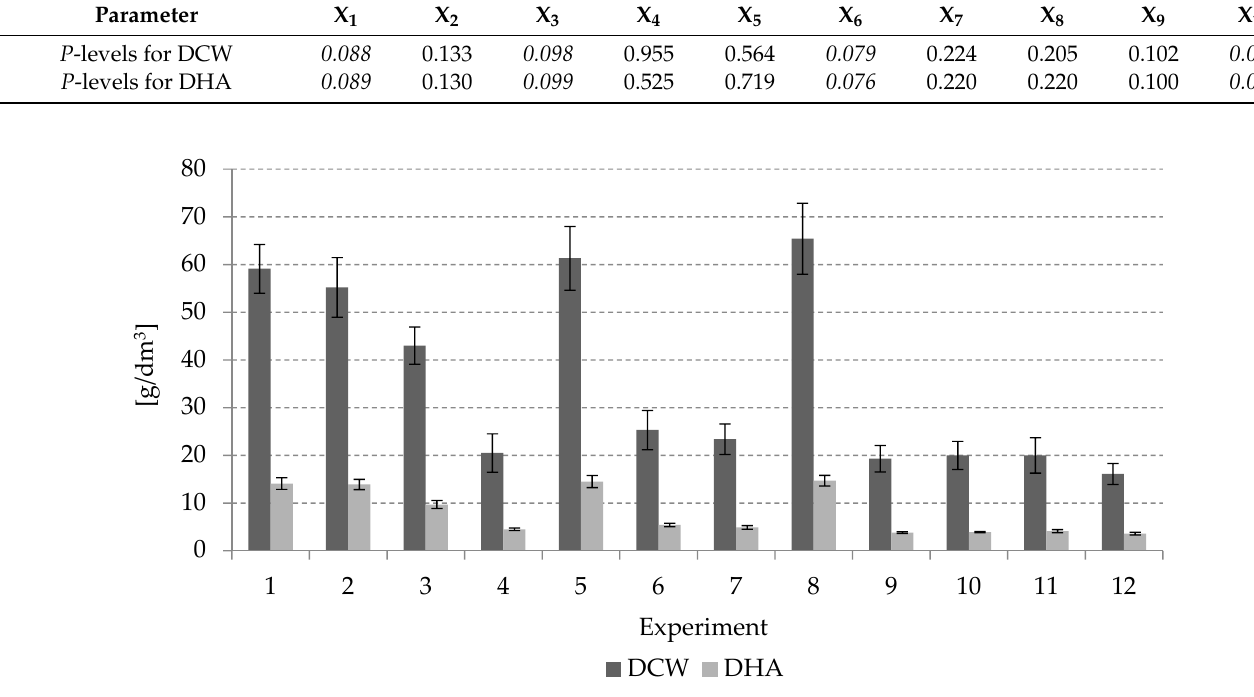
Figure 1. Biomass dry cell weight (DCW) and DHA concentrations obtained in the experimental series designed using the Plackett–Burman method.